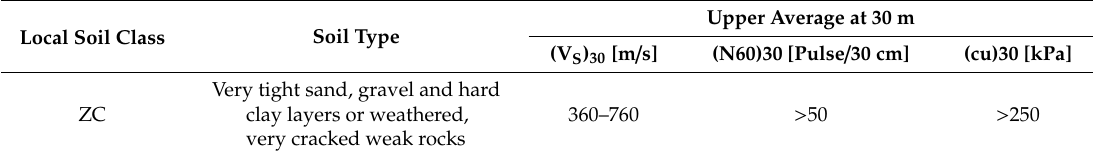
Table 3. Local soil class type ZC [6].